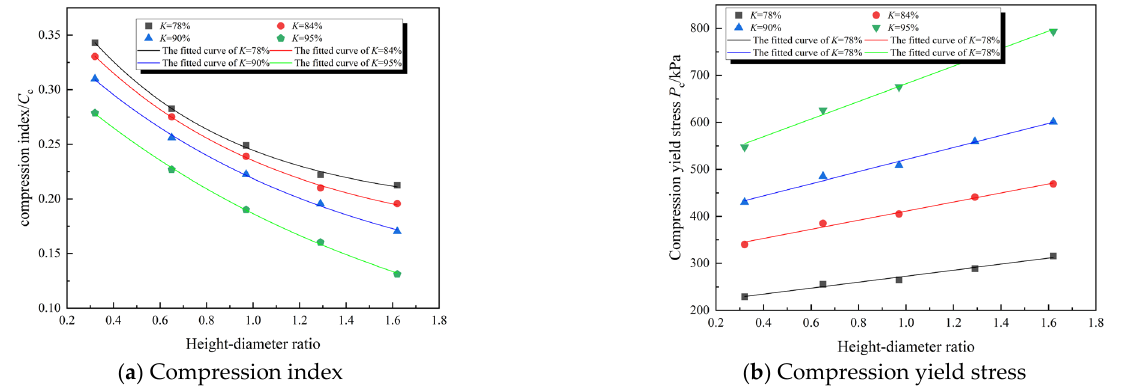
Figure 7. The relationship between compression parameters and H/D ratios. Table 2. Fitting results of compression parameters.